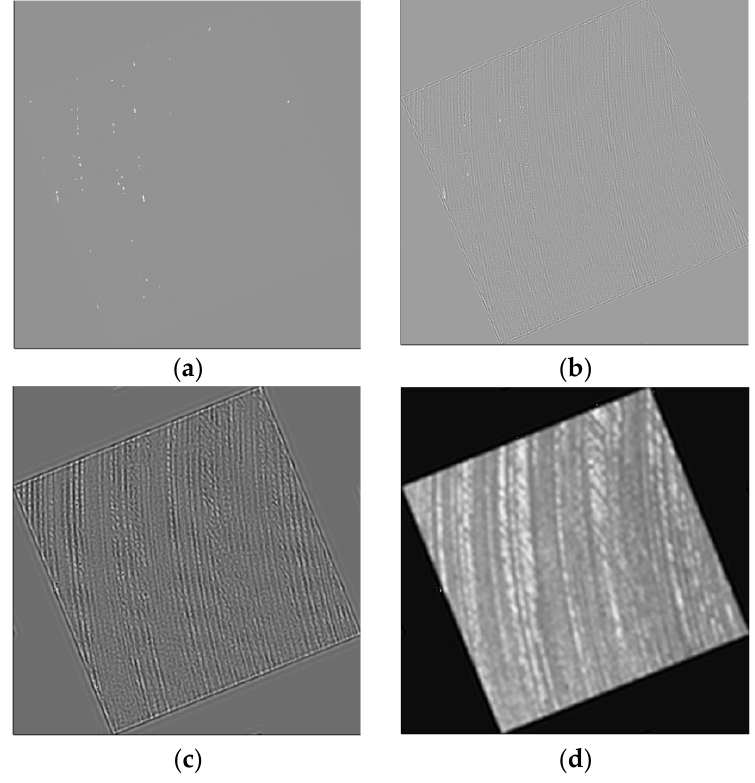
Figure 14. Image DTCWT ( a ) w 1 ( t ); ( b ) w 2 ( t ); ( c ) w 3 ( t ) and ( d ) c 3 ( t ).